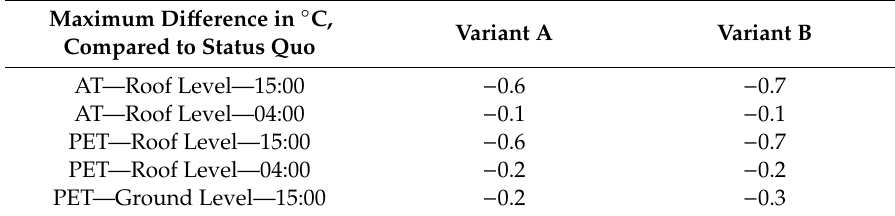
Table 1. Di ff erence of air temperature (AT) and physiological equivalent temperature (PET) of Status Quo compared to the di ff erent design Variants A and B at the ground and roof level at day (15:00) and night-time (04:00).